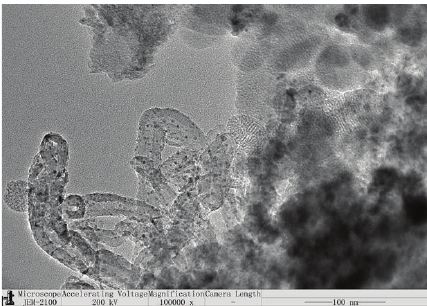
Figure 4: TEM image of the PPy/T-CNs nanocomposite. The amount of Py in the nanocomposite was